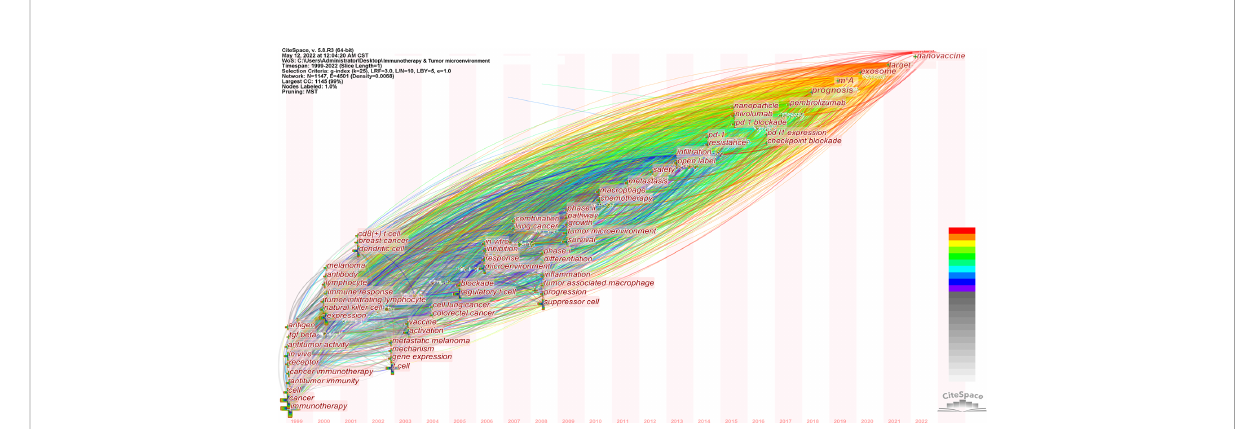
FIGURE 9 Keyword time zone view of immunotherapy-TME studies. Note: For 1999 – 2017, keywords with co-occurrence ≥ 300 are displayed; for 2018 – 2022, the yearly top 1 keywords are displayed with co-occurrence frequencies. Cross and word sizes denote co-occurrence frequencies link co-occurrence associations. Nodal point and line colors indicate years, ranging from grey to red between 1999 and